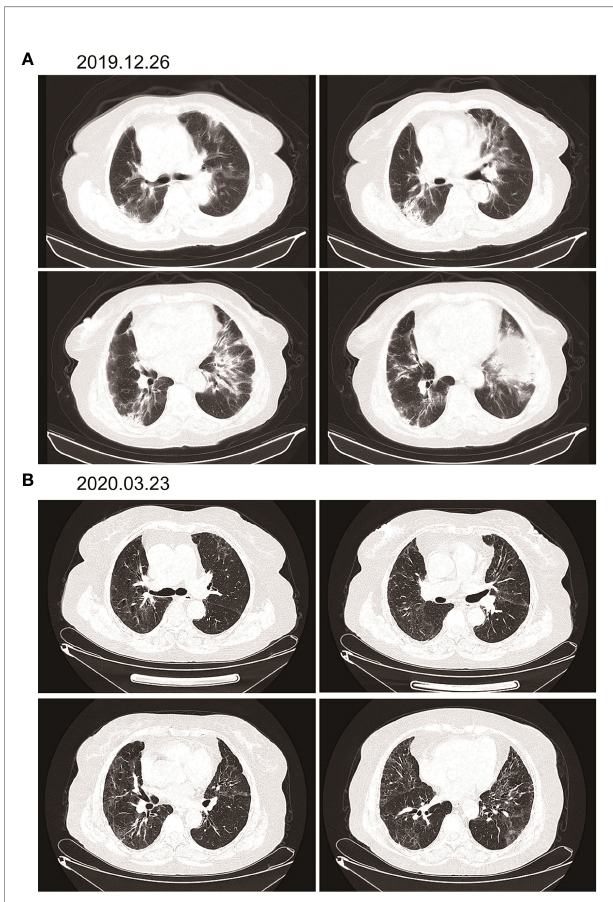
FIGURE 4 | Immunotherapy-related pneumonia before and after methylprednisolone therapy. (A) There are cords and patchy shadows in both lungs, with blurred boundaries and in fl ammatory changes, that are bigger than before. (B) Frequent strand shadows and patchy shadows are seen in both lungs, and the boundary is blurred, and the area is smaller than